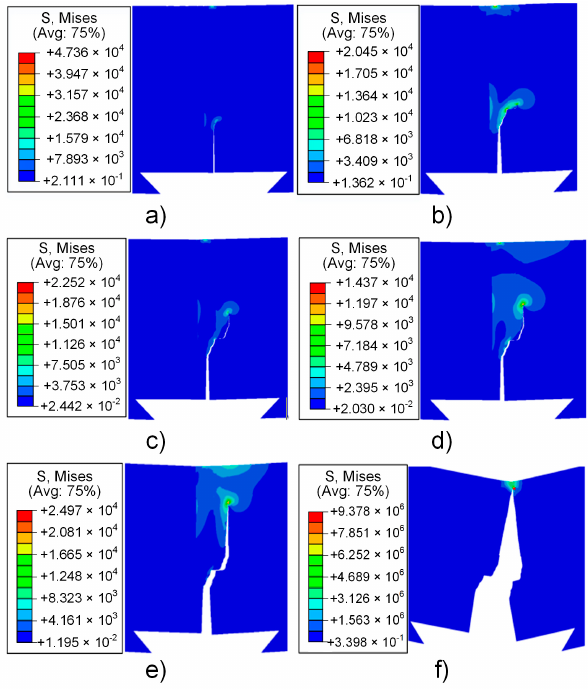
Figure 14. Three-point bending crack propagation simulation ( a ) step 1; ( b ) step 2; ( c ) step 3; ( d ) step 4; ( e ) step 5; ( f ) step 6.